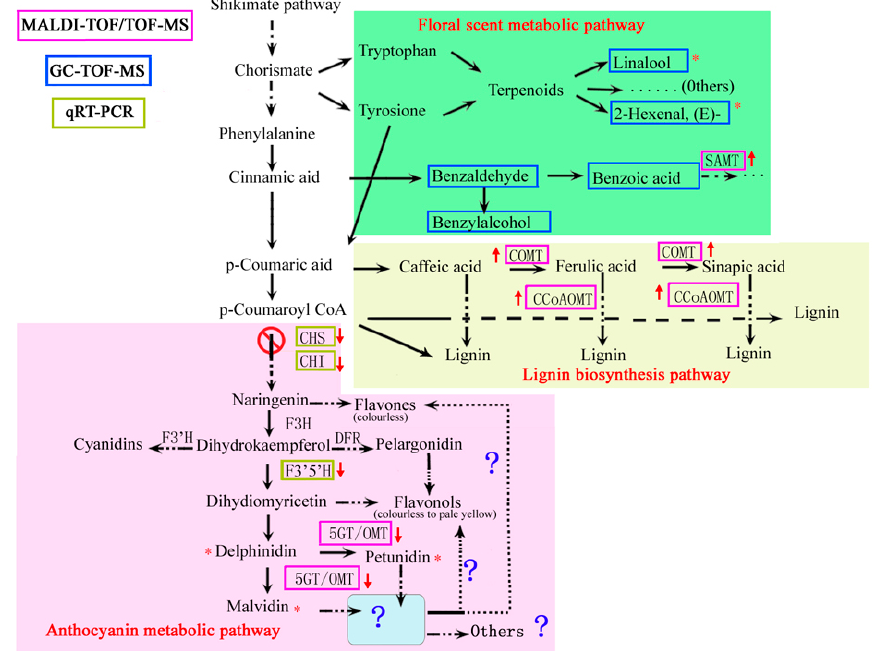
Figure 8. A putative metabolic map described the pathway including the floral scent metabolic pathway and lignin pathway during the degradation of anthocyanins in B. acuminata petals. The diagram shows the di ff erent pathways. The diagram summarizes the results of qRT-PCR, MALDI-TOF / TOF and GC-TOF-MS analyses. The dashed black arrows represent several consecutive enzymatic steps. The color of the box indicates the method by which they were identified. The red arrow represents up or down and the symbol with * in the picture is expressed as an important substance identified in the petals. Enzymes: SAMT, salicylic acid carboxyl methyltransferase; COMT, catechol O-methyl transferase; CCoA-OMT, ca ff eoyl-CoA O-methyl; OMT, Anthocyanin- O -methyl transferase. Genes: CHS , chalcone synthase; CHI , chalcone isomerase; F3 (cid:48) 5 (cid:48) H , flavonoid 3 (cid:48) 5 (cid:48)